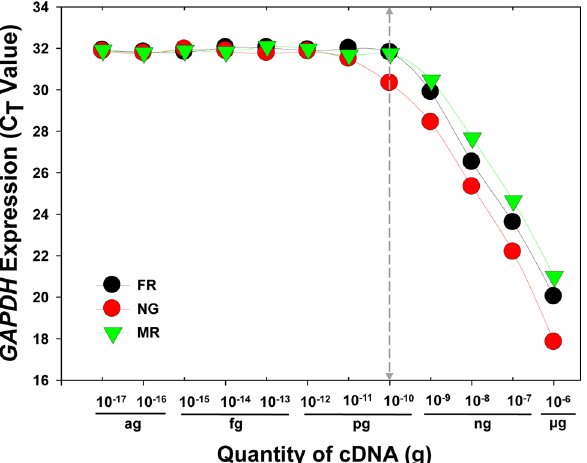
Figure 1. Optimal cDNA concentrations for RT-qPCR analysis. cDNAs synthesized from three different tissues FR (female reproductive organ, ovary), NG (neuron ganglion) and MR (male reproductive organ, testis) were subjected to a tenfold serial dilution before engaging in the subsequent RT-qPCR analysis.